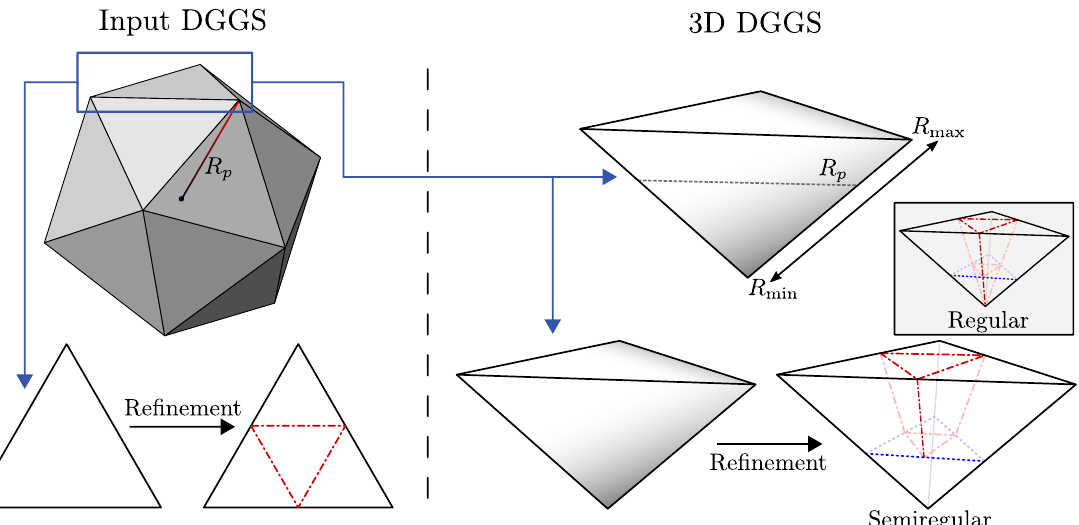
Figure 1. Overview of how the input Discrete Global Grid System (DGGS) is used to define the geometry of the three-dimensional (3D) DGGS. The faces of the initial polyhedron of the input DGGS are first extruded to create the prismatoid base cells of the 3D DGGS. For refinement, the bases of these prismatoid cells are refined using the same refinement scheme as the input DGGS and combined with a radial refinement. A semiregular refinement is suggested; however, regular refinement is also possible. A more detailed description of these processes is provided in Section